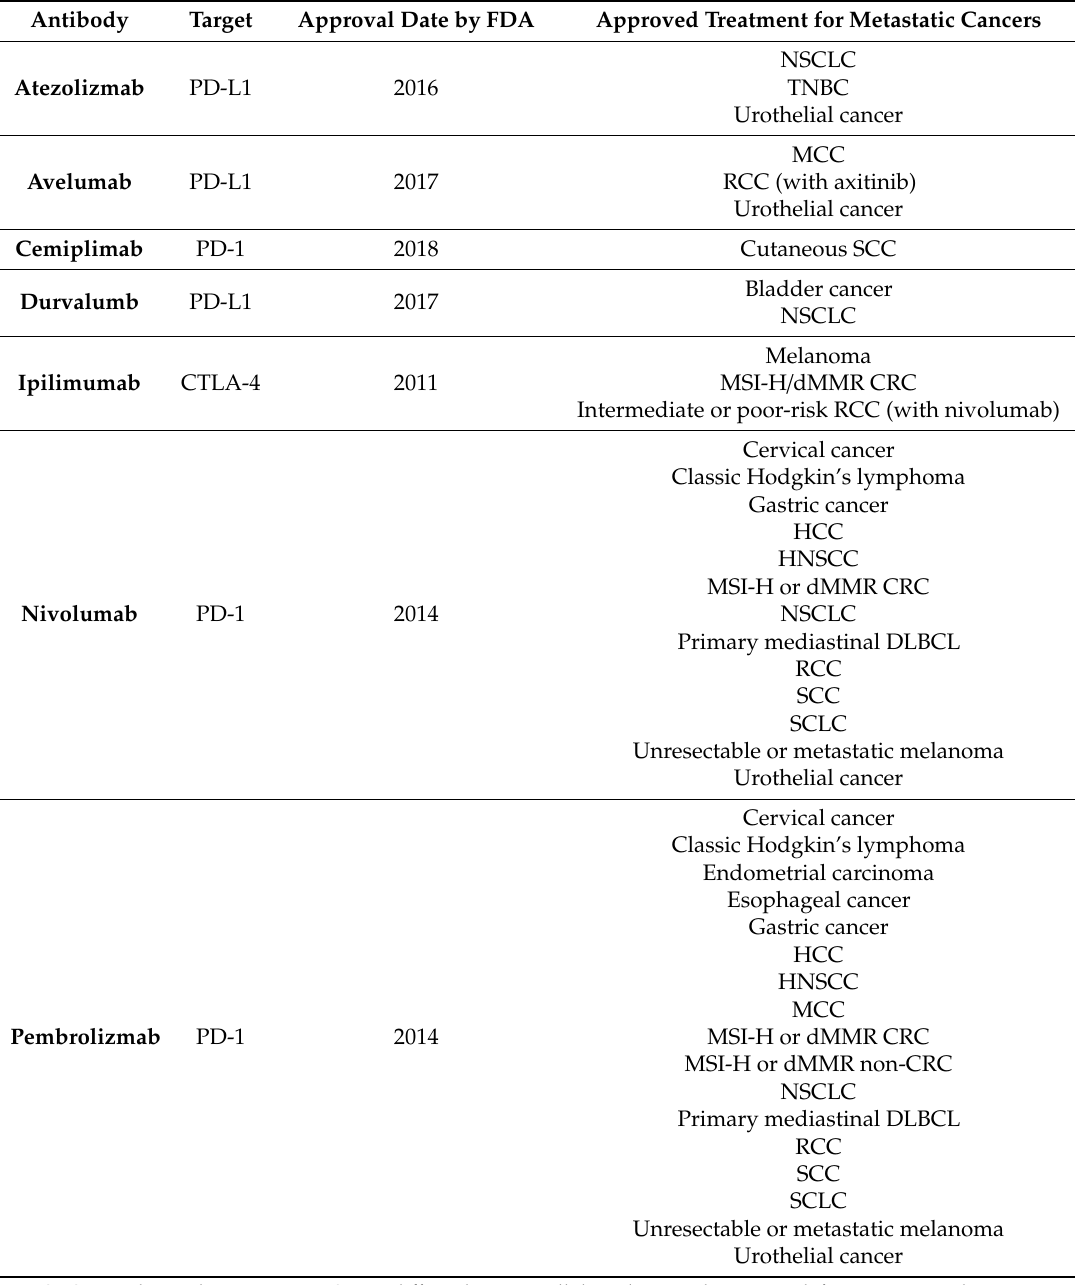
Table 1. Approved immune checkpoint inhibitors (ICIs) and their